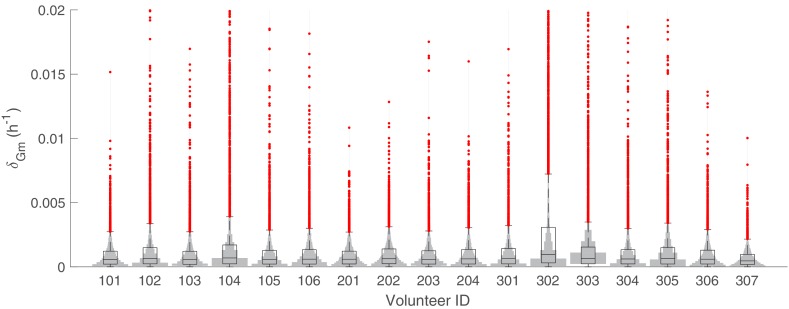
The marginal posterior distributions of the individual parameter of δGm (death rate of circulating gametocytes) for all 17 volunteers.The violin plots (gray area) show the distributions of 5000 posterior samples. Box plots show the 25%, 50% (median) and 75% quantiles with outliers indicated by red dots. Relevant details of the individual parameter are provided in the Materials and methods in the main text.